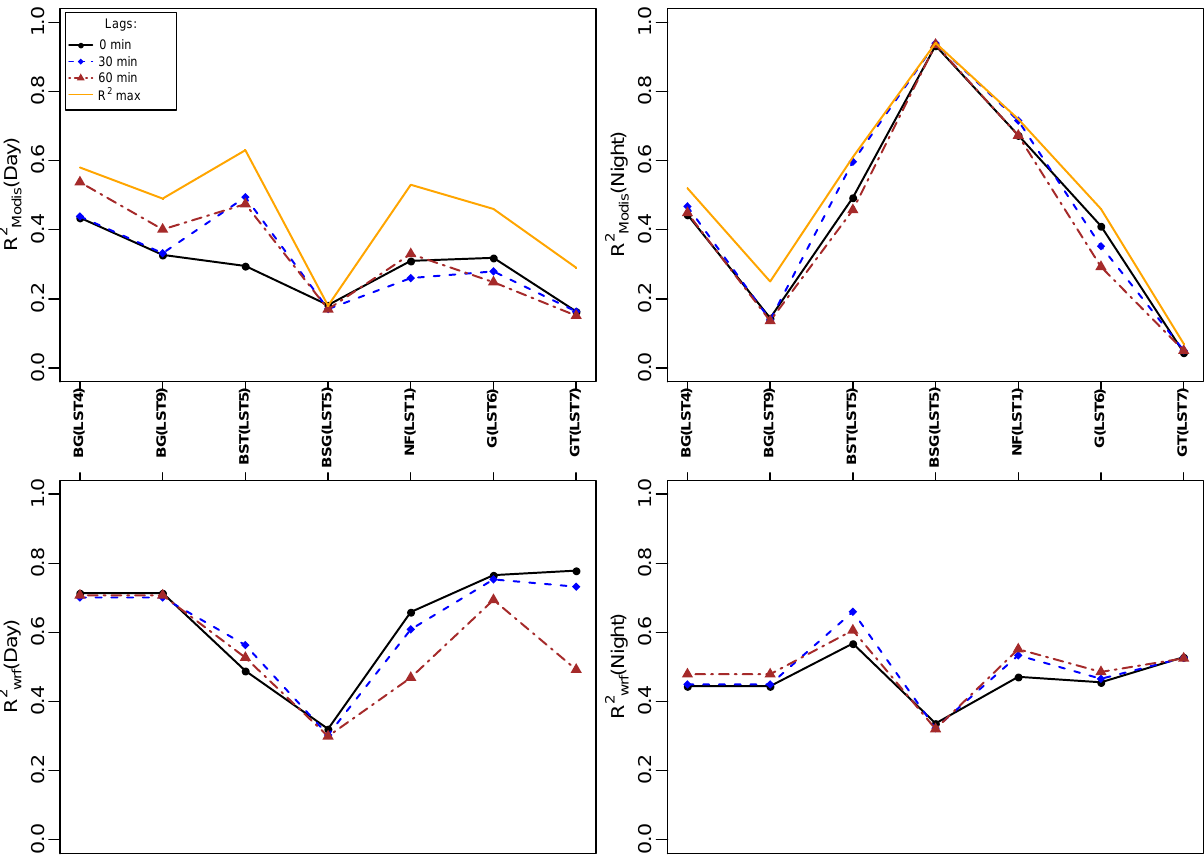
Figure 12. Correlations of day and night time-series of the three datasets over various LC types considering different time-lags (BG: Barren-Gravel, BST: Bush-Scrub-Top, BSG: Bush-Scrub-Ground, NF: Native-Forest, G: Grassland and GT: